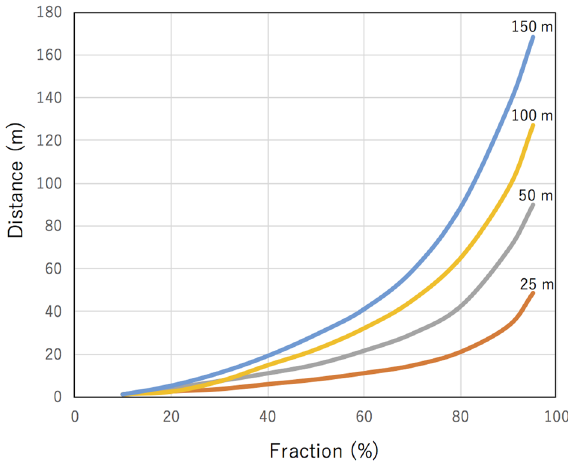
Figure 11. Fraction of the number of muons out of the total number of muons as a function of the distance from the shore line for different distances between the MSM and the shoreline ( D ): 25 m (red line), 50 m (gray line), 100 m (yellow line), and 150 m (blue